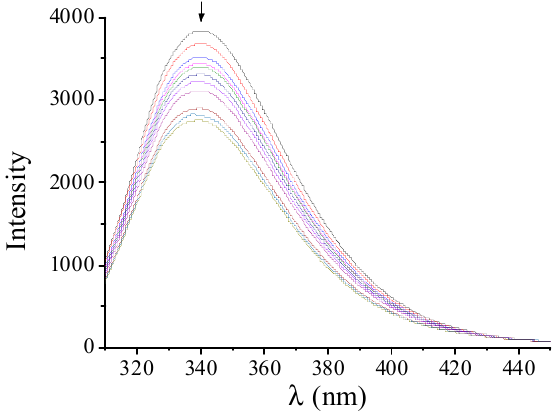
Figure 4. Fluorescence emission spectra ( λ ex = 295 nm) of bovine serum albumin (BSA) (3 μ M) in buffer solution (containing 15 mM trisodium citrate and 150 mM NaCl at pH 7.0) in the presence of increasing amounts of NL004 ( r = [NL004] / [BSA] = 0–6) . The arrow shows the changes upon increasing amounts of NL004. Table 2. Comparison of the spectroscopic data (% of BSA fluorescence quenching), the quenching and the binding constants of NL004 and NAP for BSA (k q ,